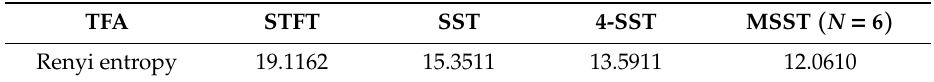
Figure 2. TFRs provided using ( a ) STFT; ( b ) synchrosqueezed transform (SST); ( c ) 4-SST; and ( d ) multi-synchrosqueeezing transform (MSST) ( N = 6). Table 1. Renyi entropy values of